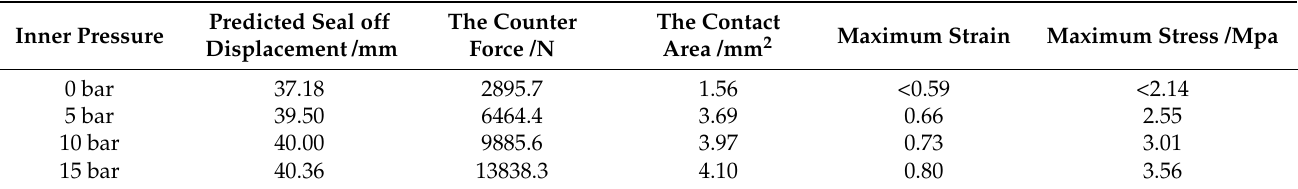
Table 5. The predicted seal off displacements together with the counter force, contact area and the maximum strain and stress deduced from the obtained